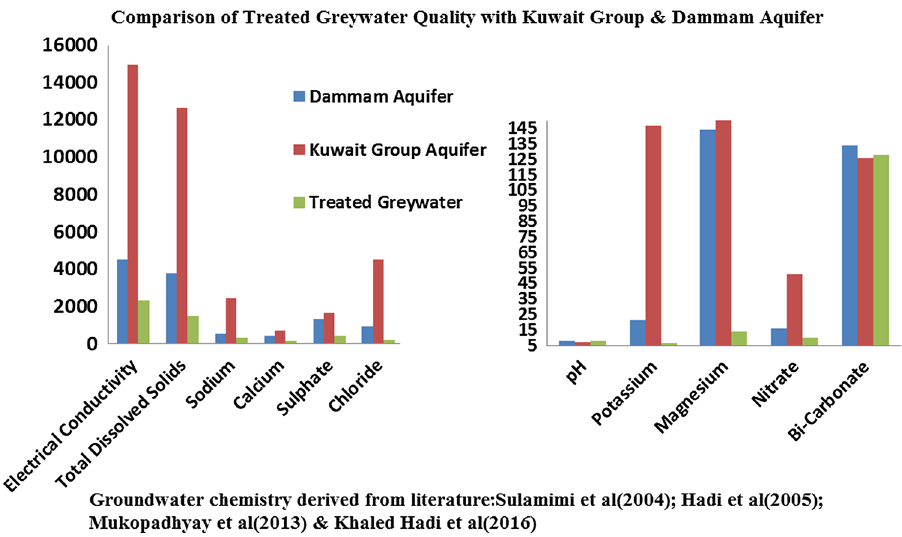
Fig. 5 Graphical representa- tion of comparison of treated greywater quality with Kuwait Group and Dammam